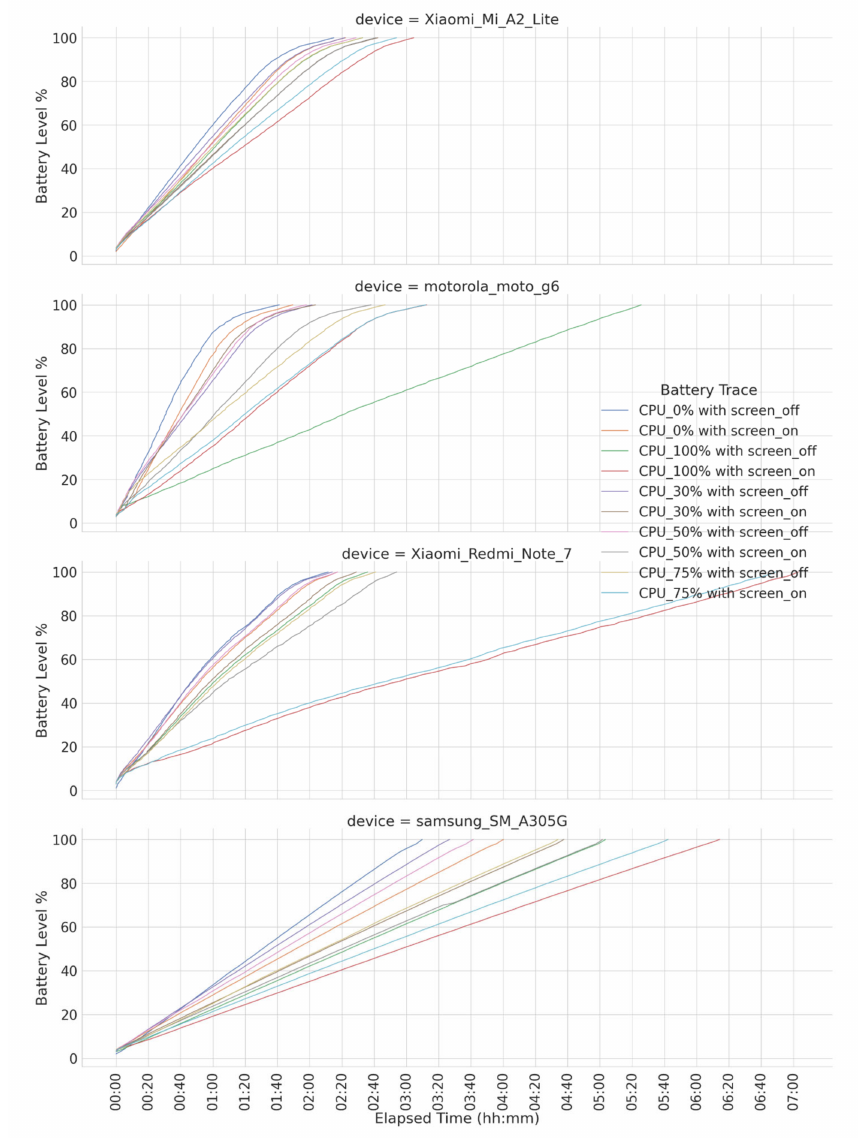
Figure 3. Charging traces for smartphones considered in the